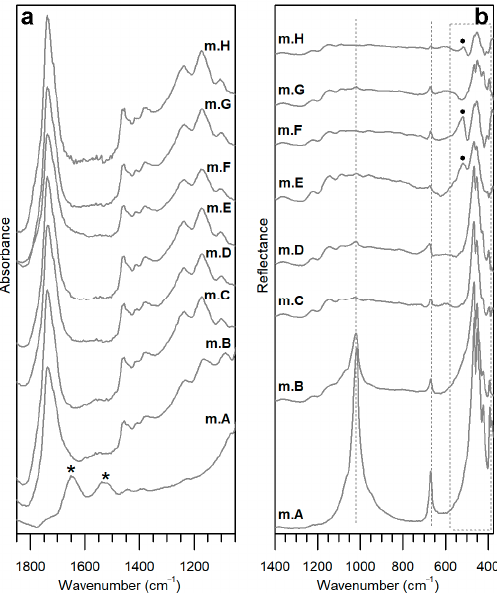
Figure 5. Representative reflection FT-IR spectra collected on the mock-ups in correspondence of the areas characterized by talc concentration in the ground of 1%. The spectra after ( a ) and before ( b ) Kramers-Kronig (KK) transformations are displayed for the study of organic and inorganic compounds, respectively. Marker bands of K-caseinate (asterisk), talc (dotted line and rectangle), and hematite (round) are highlighted.